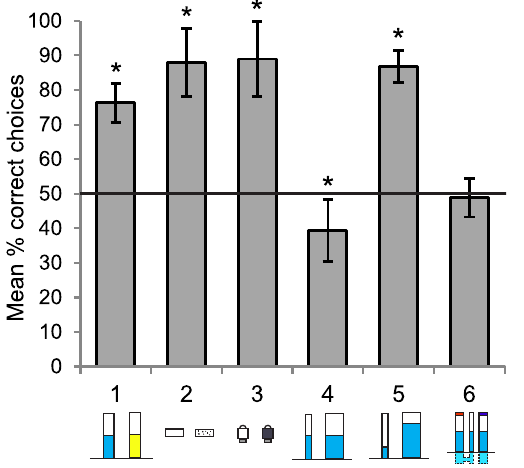
Figure 2. Average performance in all six experiments. Mean proportion of choices made to the correct option, over 20 trials, in each experiment. (1: Sand v Water, 2: Sinking v Floating, 3: Solid v Hollow, 4: Narrow v Wide, 5: High v Low water levels, 6: U-tube.) Error bars are 6 2 SE. * = significantly different from chance (binomial tests, p , 0.001). p value , 0.001), the remaining bird (R) approached significance at 20 trials (binomial test, p = 0.01, ns with a Bonferroni adjusted alpha level of 0.007).